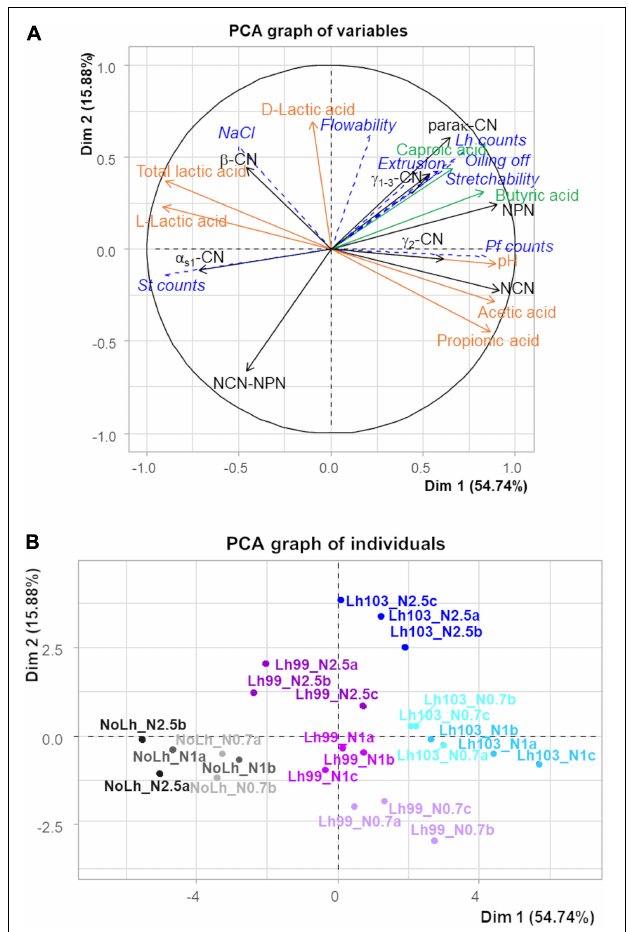
FIGURE 4 | Variable map (A) and individual factor map (B) of the two first principal components of principal component analysis of 16 biochemical variables, which characterize proteolysis (in black), lipolysis (in green), and lactic and propionic acid fermentation (in orange) in Swiss cheeses manufactured with different Lactobacillus helveticus strains and NaCl contents, at the end of the ripening (48 days). A set of 8 other variables that describe microbial counts, NaCl content, and techno-functional properties are projected as supplementary variables (in italics and blue dashed lines). Samples codes are as follows: L. helveticus strain: Lh103 (CIRM-BIA103), Lh99 (CIRM-BIA99), or NoLh (without L. helveticus ), followed by the NaCl content: N1 (regular salt concentration, i.e., 0.45 g NaCl/100 g cheese), N0.7 (N1 × 0.7), and N2.5 (N1 × 2.5). Triplicates, coded a, b, and c, were performed for each salt concentration and L. helveticus strain used, except NoLh cheeses manufactured in duplicate, coded a and